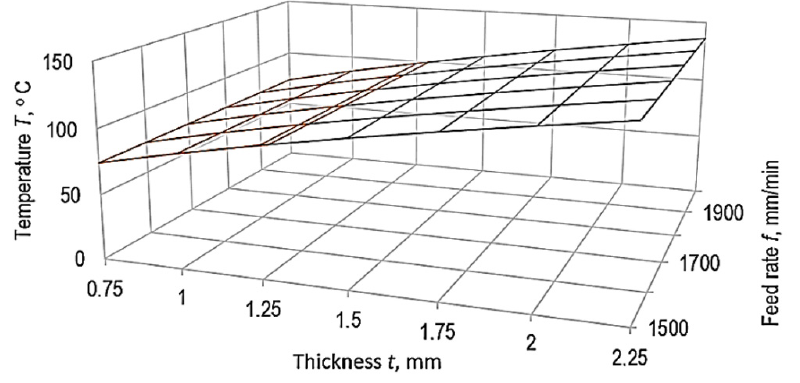
Figure 7. Influence exerted by the workpiece thickness t and feed rate f on the sample temperature when using coolant ( s d = 0.5 mm).